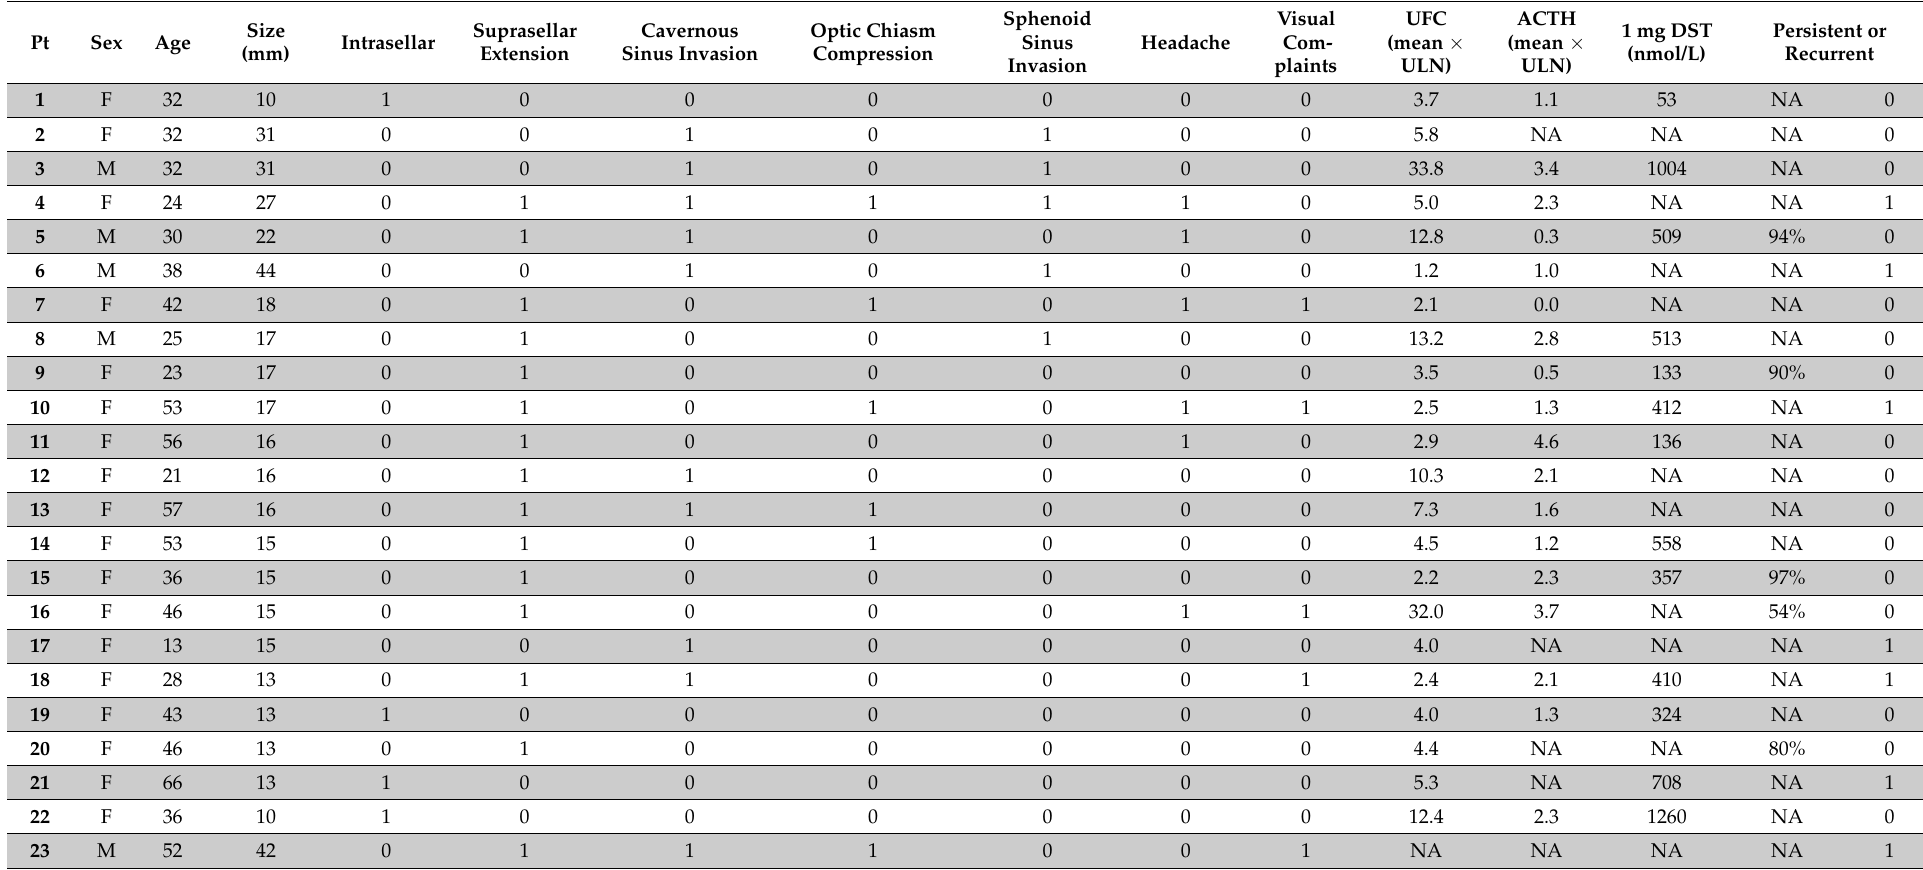
Table 2. Corticotroph macroadenomas. Biochemical and radiographic characteristics of corticotroph macroadenomas. Two patients with macroadenomas are not